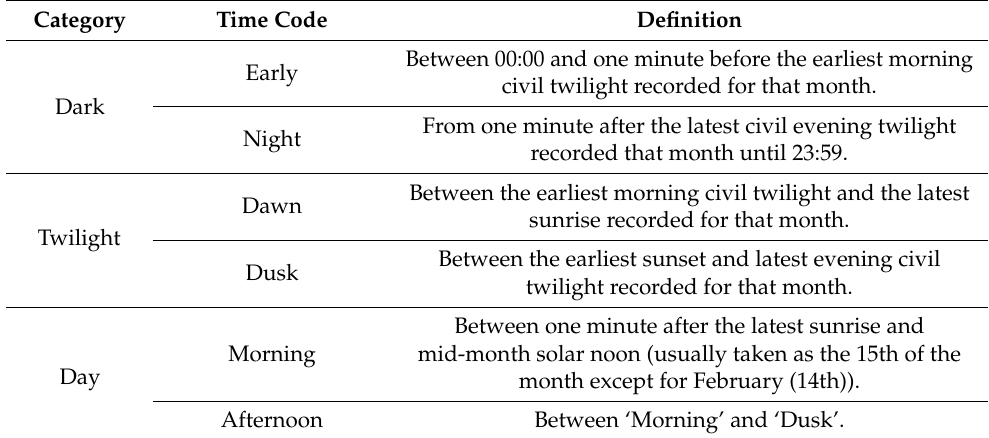
Table 1. Definitions for each time code when taking behavioural data from the camera trap